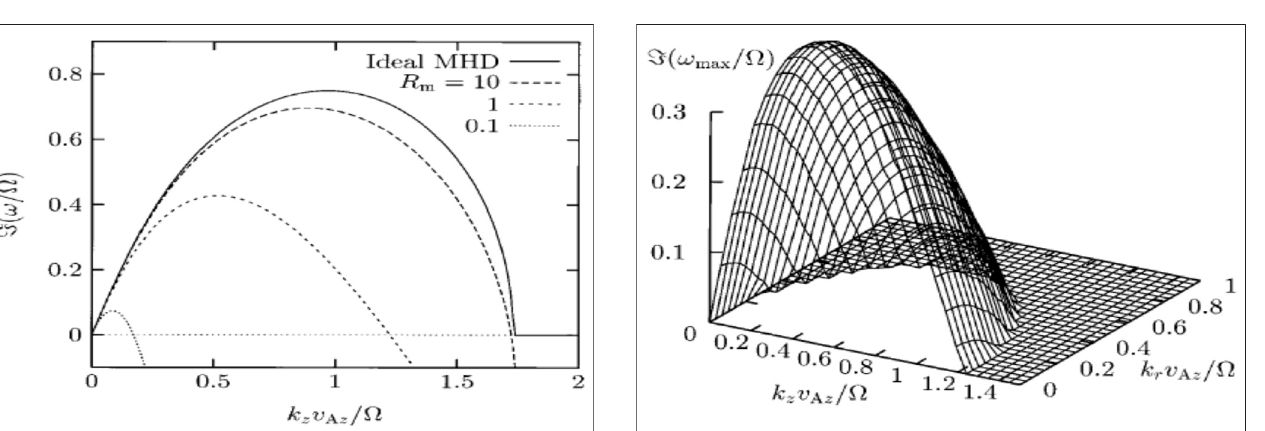
FIGURE 12 | MRi growth rate as a function of the vertical wavenumber. The modes shown in this fi gure are on the unstable branch for the case of k r (cid:1) 0.TheresultoftheidealMHDcaseisshownasasolidcurve.Othercurvesare diffusive cases that have different values of the magnetic Reynolds number. Adapted from Sano and Miyama (1999). © AAS. Reproduced with permission